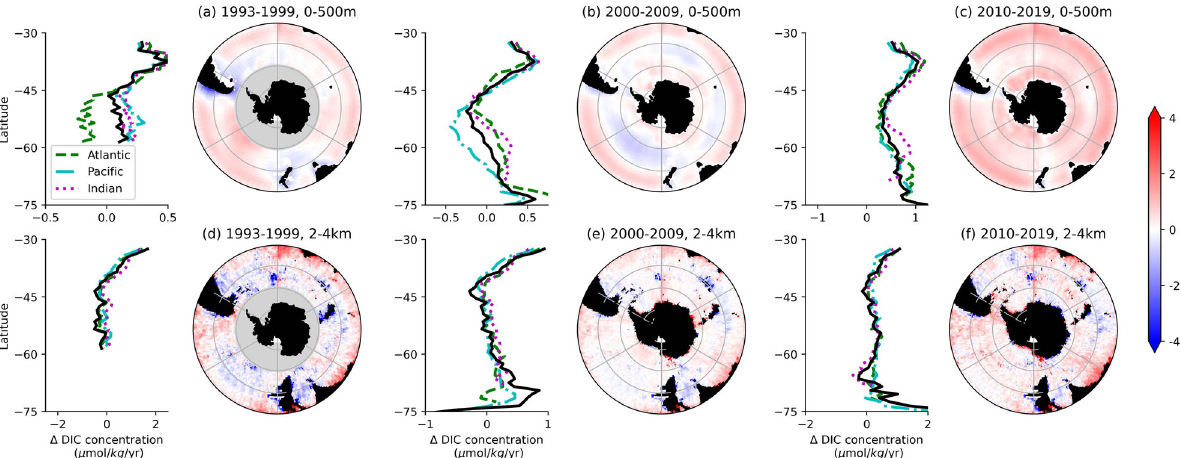
Fig. 2 Linear trends in dissolved inorganic carbon (DIC) concentration. a – c averaged over top 500 m, ( d – f ) averaged over 2 − 4 km depth. Values are calculated over: ( a , d ) 1993 – 1999, ( b , e ) 2000-2009, and ( c , f ) 2010 – 2019. Linear trends outside the 5% signi fi cance level ( p ≥ 0.05) are excluded. Areas shaded in gray indicate regions of insuf fi cient data for trend calculations. Panels to the left of each colored trend plots show zonal averages for the entire Southern Ocean (black solid line), and the Atlantic (dashed green line), Paci fi c (dash-dot cyan line), and Indian sectors (dotted magenta line). Figures were made with Natural Earth. Free vector and raster map data ( naturalearthdata.com ) using Cartopy 77